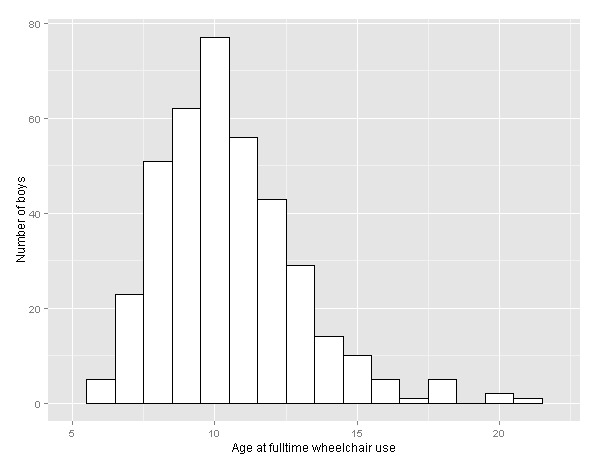
Histogram of age at loss of ambulation for the 384 males who reached that endpoint.